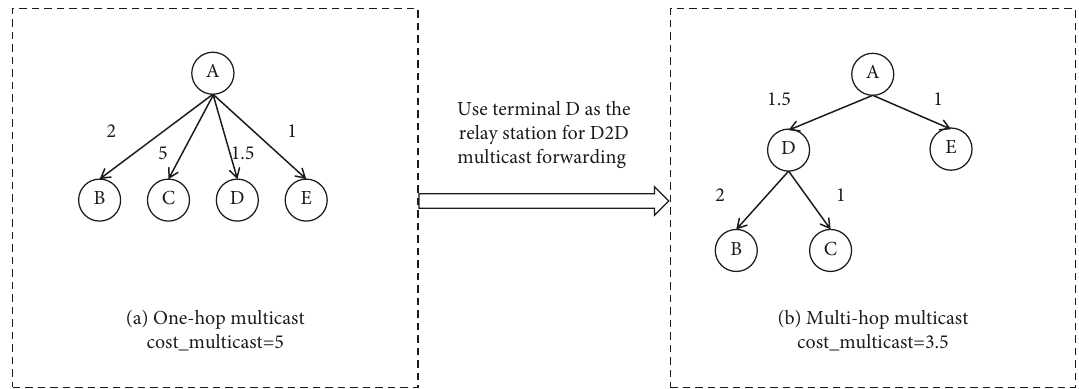
Figure 4: Example of one-hop multicast and multihop multicast. (a) One-hop multicast cost_multicast � 5. (b) Multihop multicast cost_multicaste � 3.5.